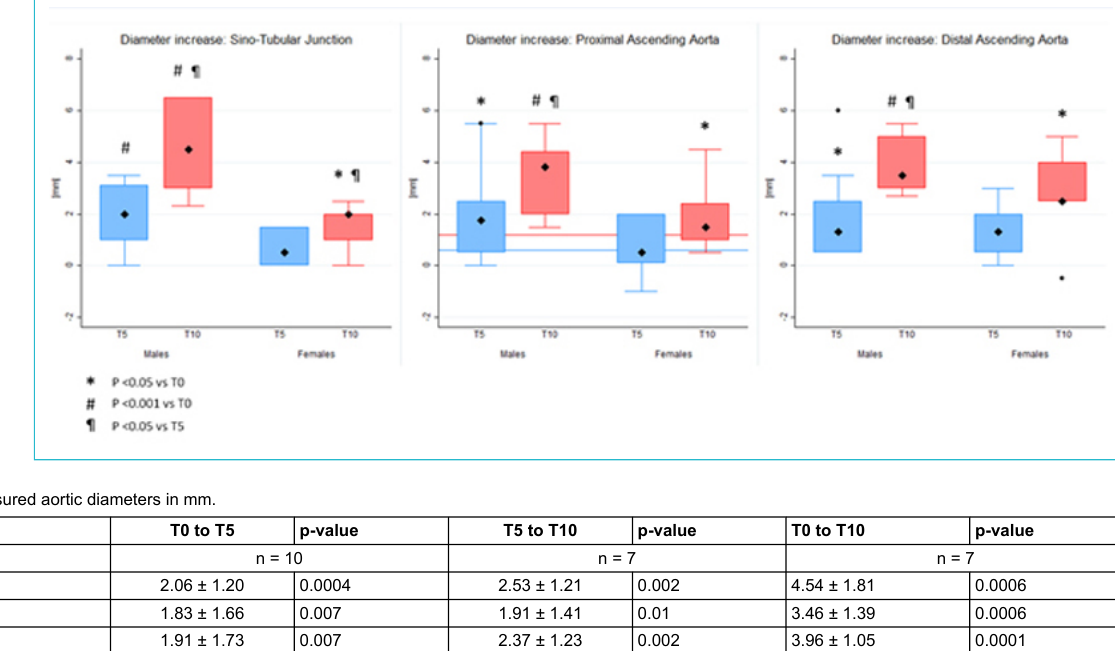
Figure 2: Progression of aortic diameters at the sino-tubular junction, proximal and distal ascending aorta between T0 and T5 and between T0 and T10 in males and females with Fabry disease. The two horizontal lines in the central panel indicate the expected progression in the gener- al population according to MESA at 5 years (blue line) and at 10 years (red line). For each diameter progression, the box indicates the 25th and the 75th percentile and the large diamond indicates the mean value. Outliers are depicted as small diamonds.